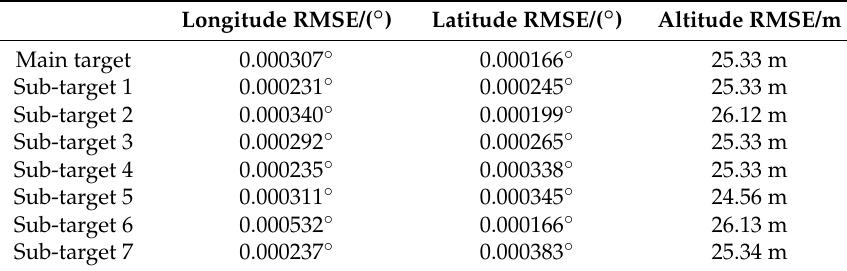
Table 2. Errors of multi-target expected location.